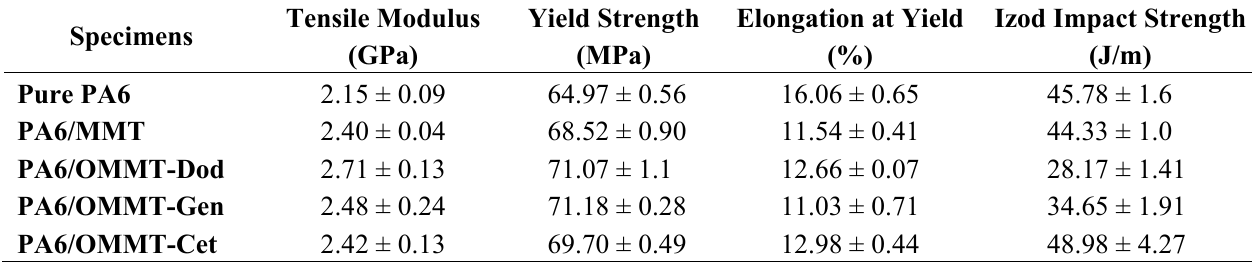
Table 2. Mechanical properties of PA 6 and its